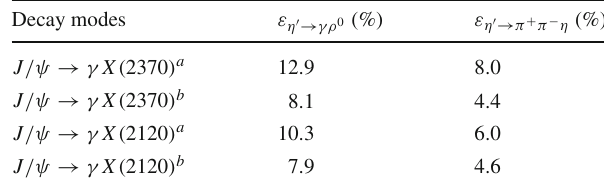
η (cid:3) , K 0 S S